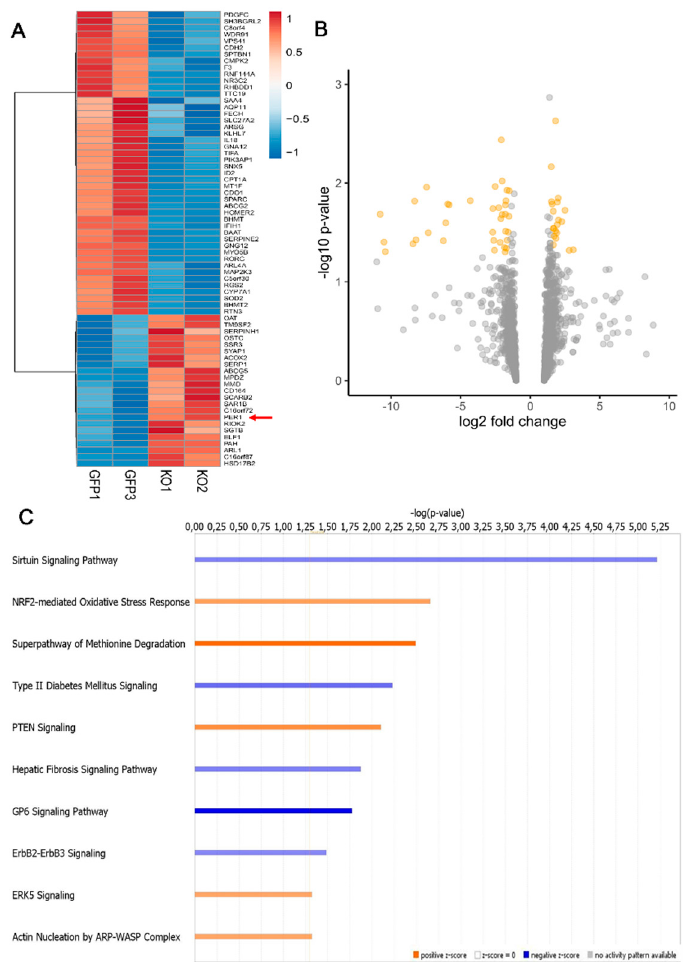
Figure 1. Histone variant macroH2A1 knockdown affects the expression level of circadian genes. ( A ) Heat-map rendering mRNA expression levels of 24 h oscillating genes upon histone variant macroH2A1 knock down in HepG2 cells. GFP1 and GFP3 indicate HepG2 control cells, KO1 and KO2 indicate macroH2A1 knocked-down HepG2 cells (biological replicates). ( B ) Volcano plot of differentially expressed circadian genes between HepG2 KD and HepG2 control cells. Indicated in orange are the genes with statistically significant different expression, i.e., p -value < 0.05 and abs (FC) > 2. ( C ) Enrichment analysis for functional categorization of the most significant